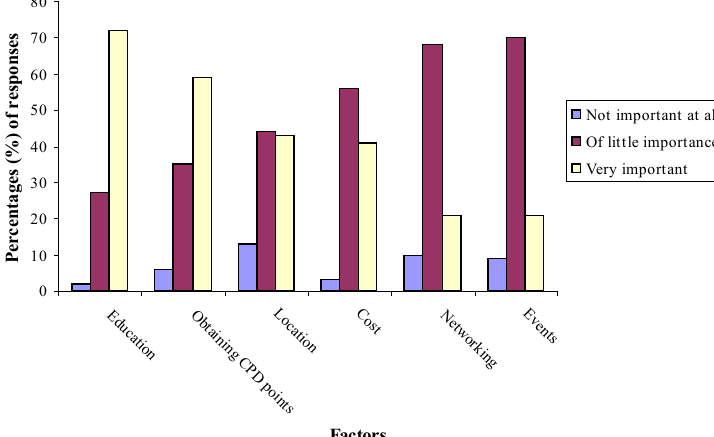
Figure 2: Practitioners’ rating of the listed factors that may influ - ence CPD attendance. Education was rated as very important by the majority of respondents (72%) while networking and events (such as social activities) were rated to be of little importance by many of the practitioners. Education refers to the quality and standard of the CPD activity